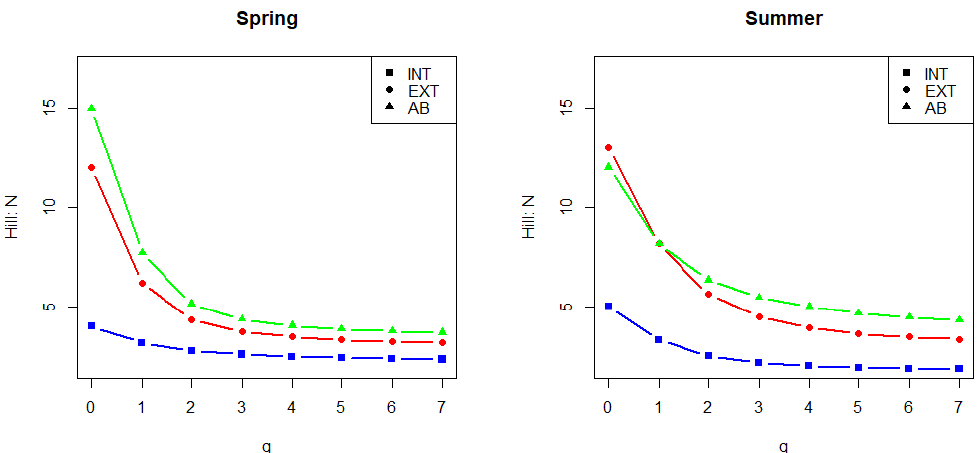
Figure 3. Hill diversity (Nq) of differently cultivated vineyards at spring ( left ) and summer ( right ). INT: Intensively cultivated; EXT: extensively cultivated; AB: abandoned.